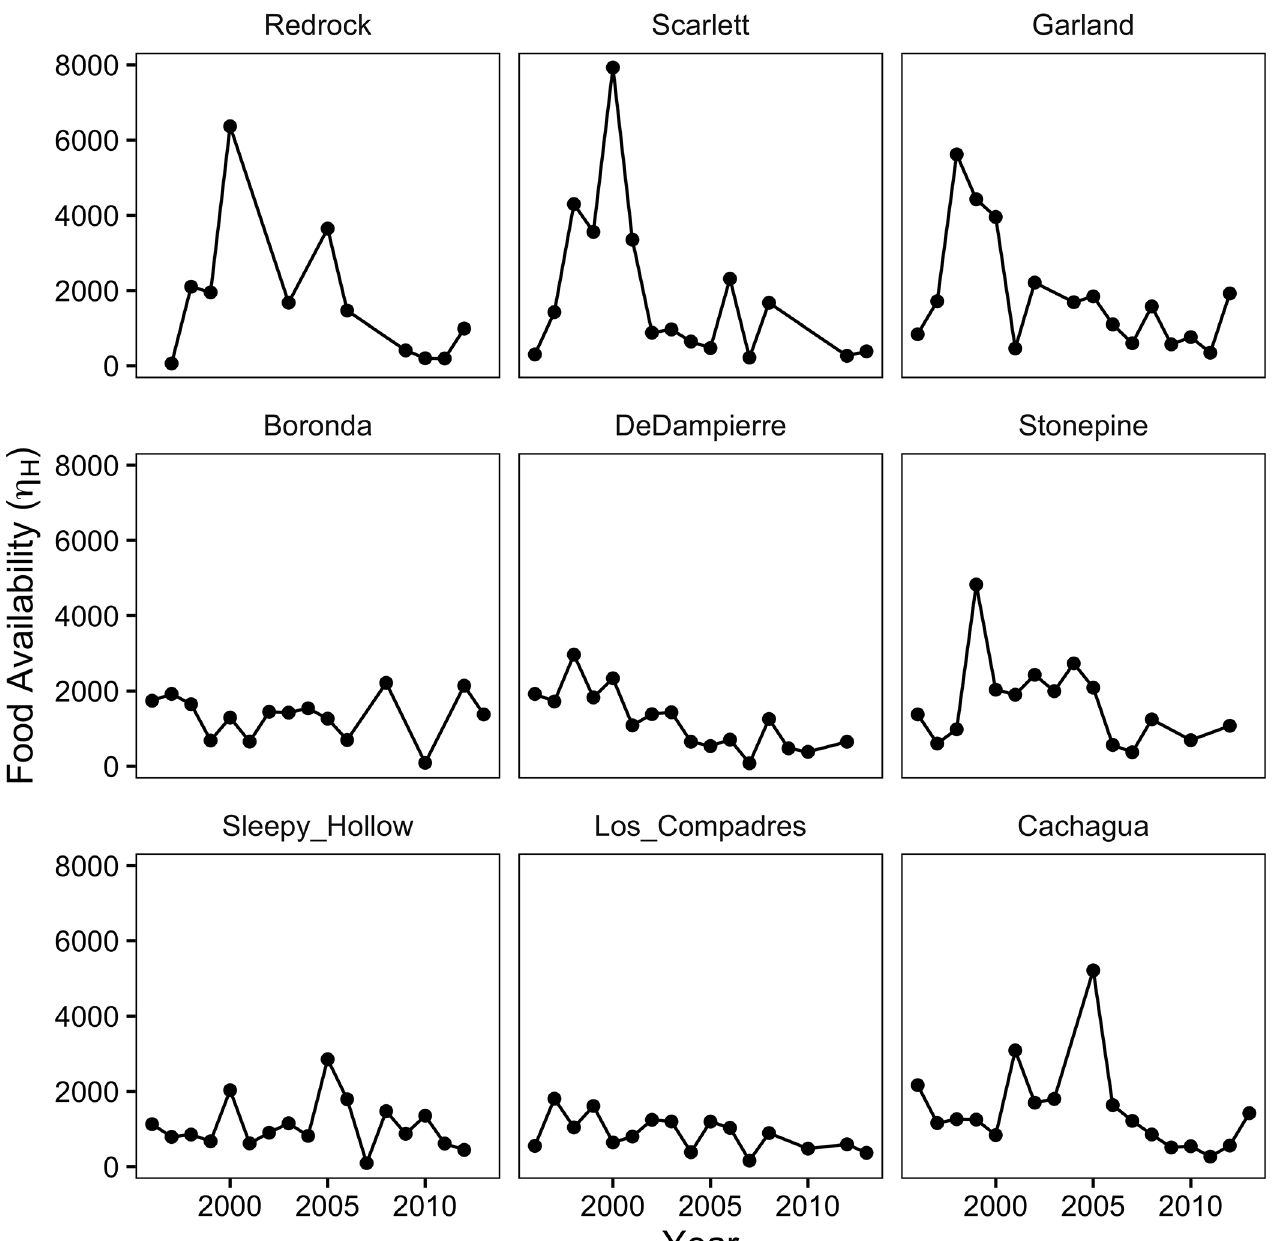
Fig 5. Inferred food availability at nine survey sites during 1996–2013. Sites are arrangedhorizontallyin order from lower to upper river. The site- and year-specific food availability η H was an estimated parameter of the bioenergetics model, which was fit to fish-size data and water- temperature data (S1